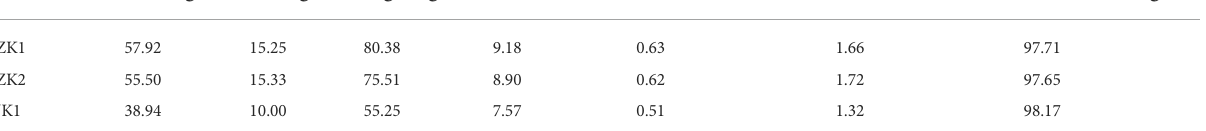
TABLE 6 Conversion of Na, K, and Mg ion concentrations to percentage in the geothermal fl uids.